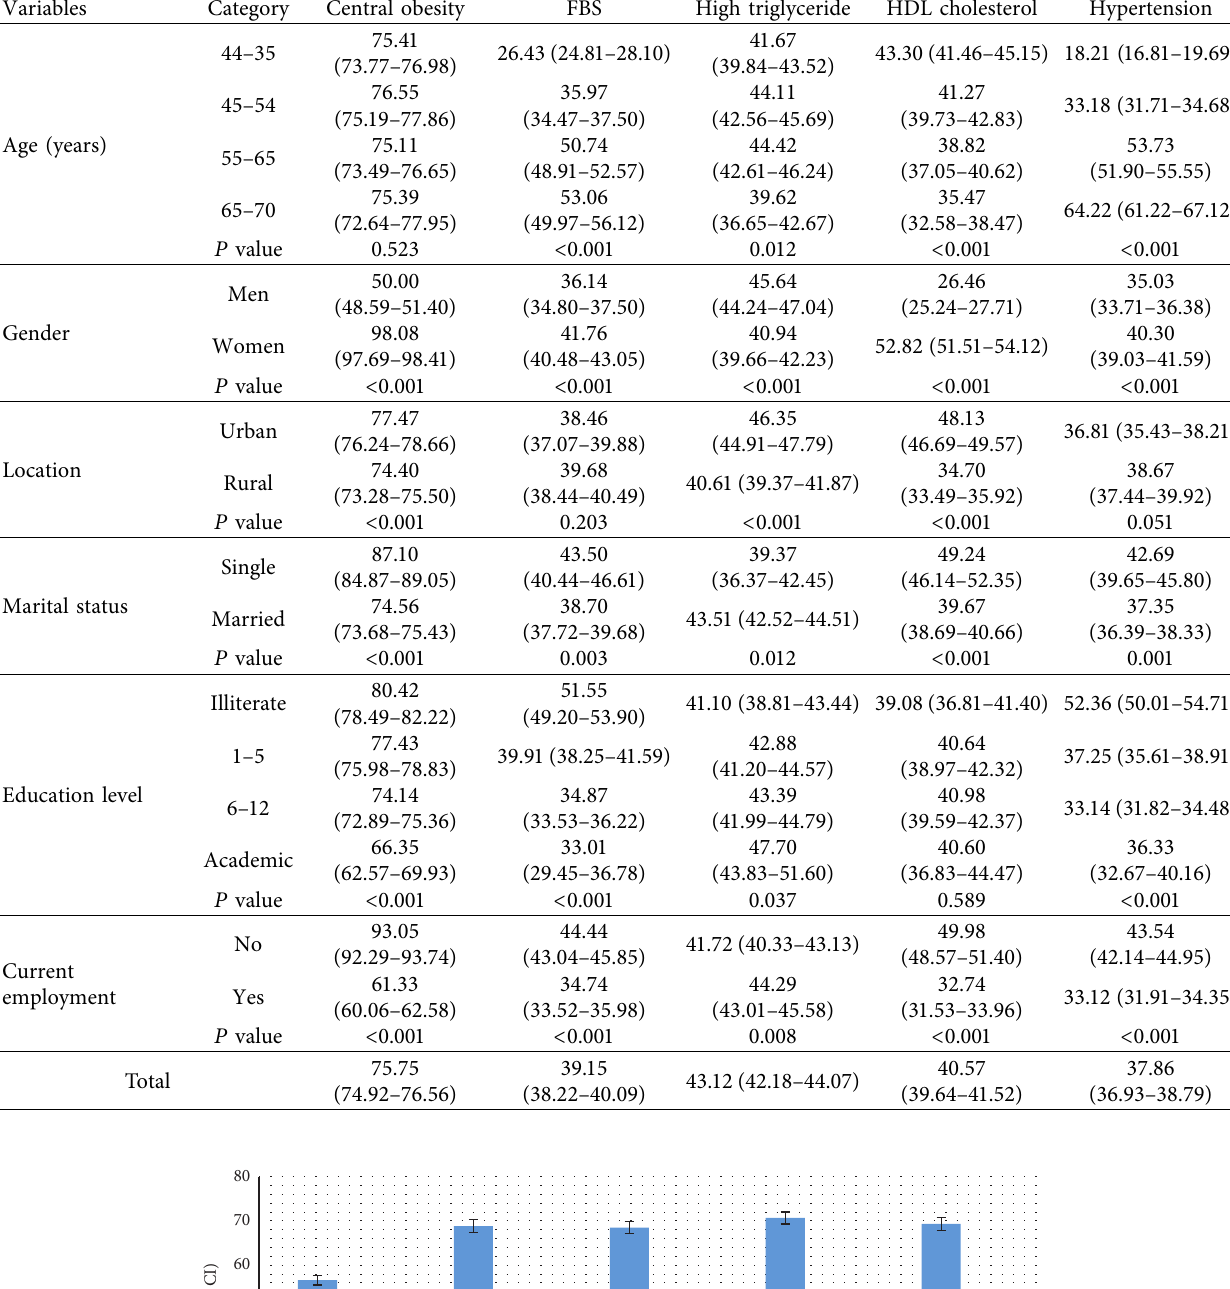
Table 4: Prevalence of metabolic syndrome components by demographic characteristics based on IDF